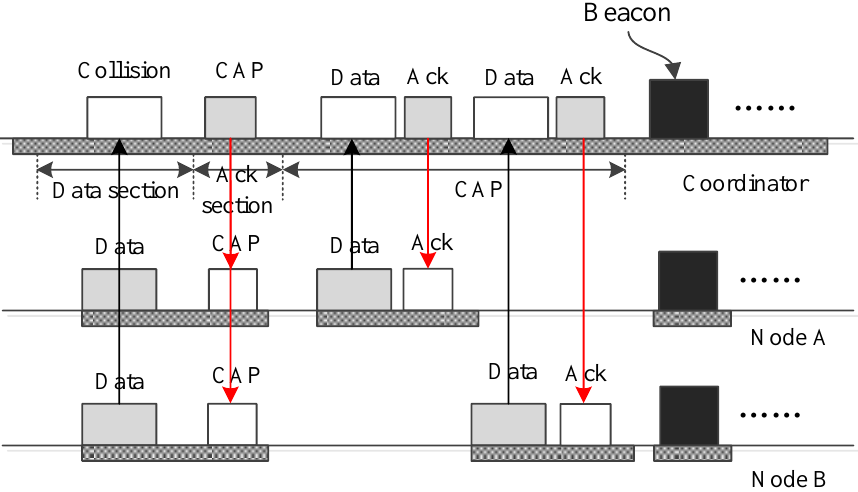
Figure 10. The case that there is a